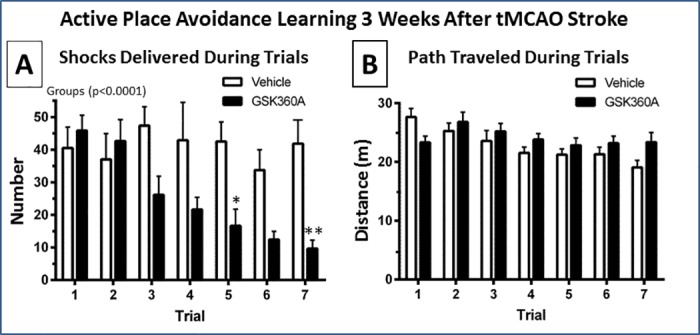
Effect of GSK360A on APA learning performance 3 weeks after tMCAO stroke.(A) The Two-Way ANOVA indicated that the group and group x trial interaction effects were significant (p < 0.01). Thus, looking at the interaction of groups over trials, the GSK360A treated group received significantly less shocks (i.e., made less errors in avoiding the shock quadrant) over trials (p < 0.01). Specifically, the GSK360A treated group received significantly less shocks in trial 5 and trial 7. (B) The effect of GSK360A was not due to differences in rat movements during the trials, as there was no significant difference in distance traveled per trial between the two groups. N = 8 rats per group. Two-Way ANOVA, followed by post hoc analysis using the Bonferroni procedure for multiple comparisons; *p < 0.05 and **p < 0.01 when compared with vehicle groups.